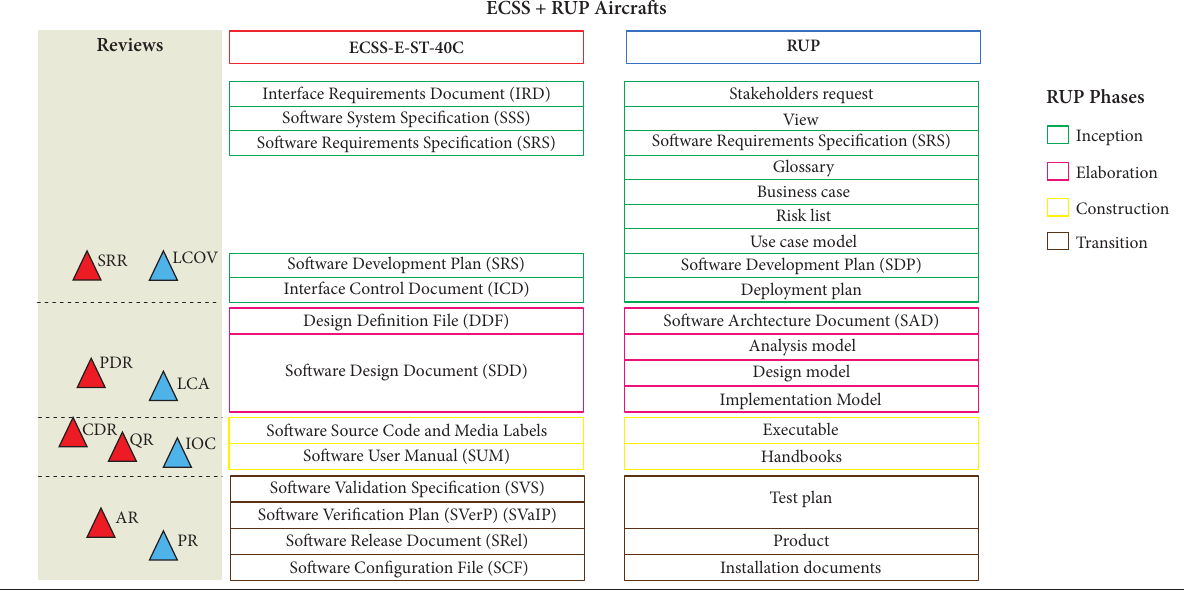
figure 5. Comparison between ECSS-E-ST-40C and RUP artifacts.